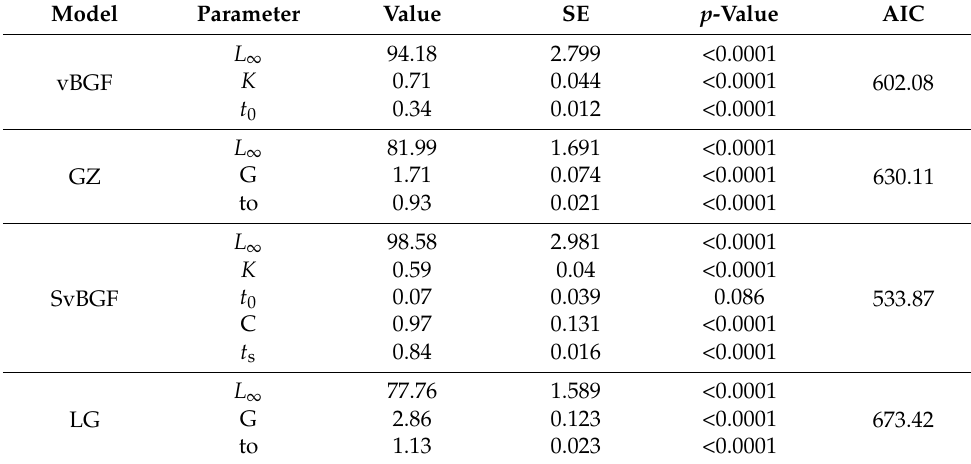
Table 1. Values for the growth parameter from the four fitted models. vBGF, von Bertalanffy growth function; GZ, Gompertz model; SvBGF, seasonalized vBGF and LG, logistic model; SE, standard error; AIC, Akaike information